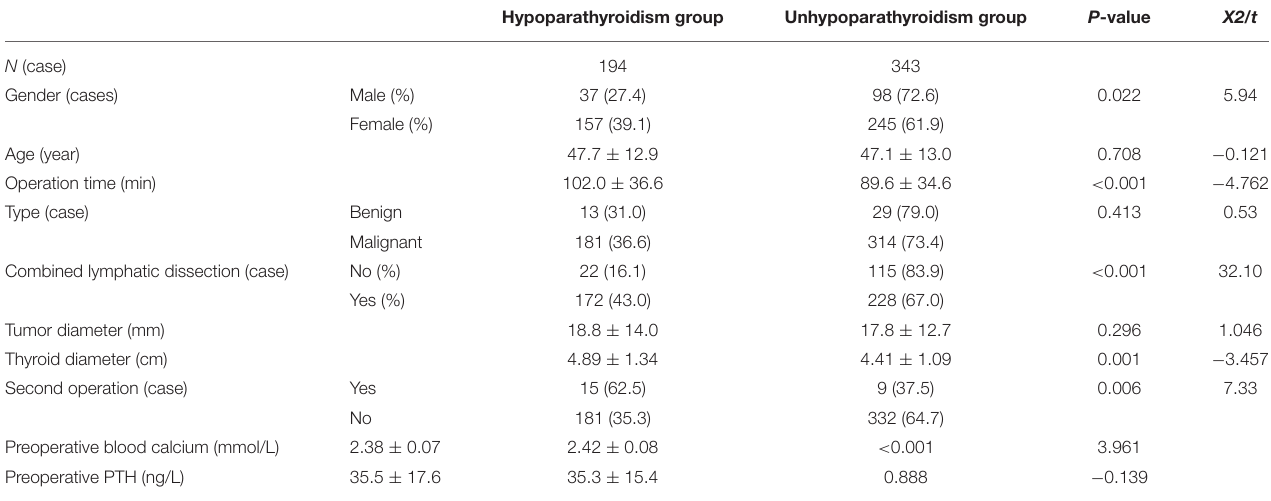
TABLE 1 | Baseline data and perioperative data of all